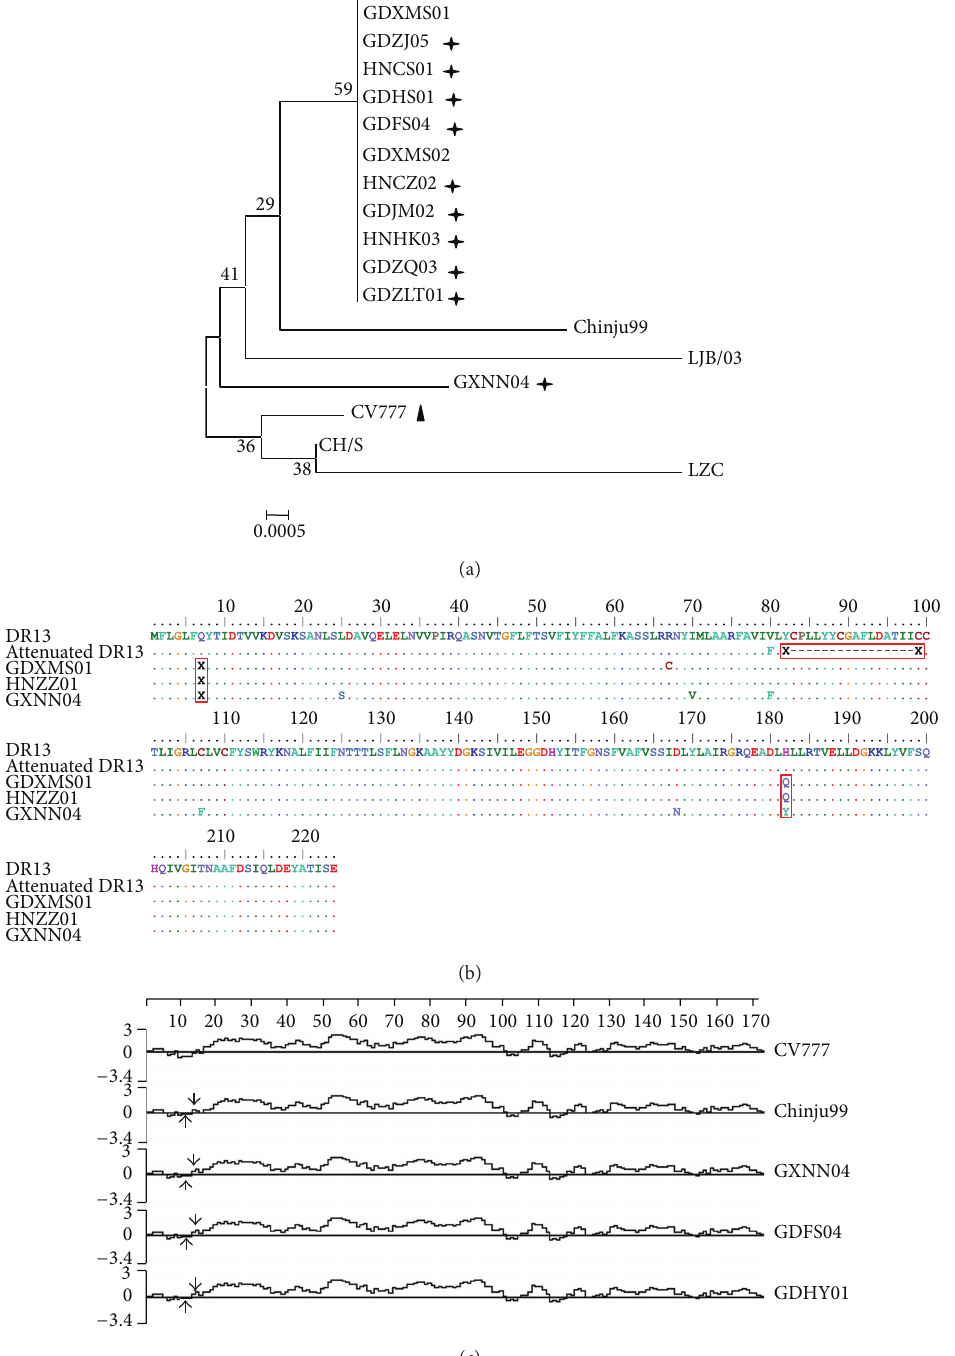
Figure 3: Comprehensive analysis of M genes from current PEDV with reference strains. (a) Phylogenetic analysis based on M aa; (b) point mutations analysis of M aa; (c) hydrophobic analysis of S aa. Phylogenetic tree is constructed by the neighbor-joining method with the MEGA 4.0 program. The percentage bootstrap support (per 1000 replicates) is indicated by the values at each node. Cross asterisk indicated present isolates; triangle indicated attenuated strains; box indicated point